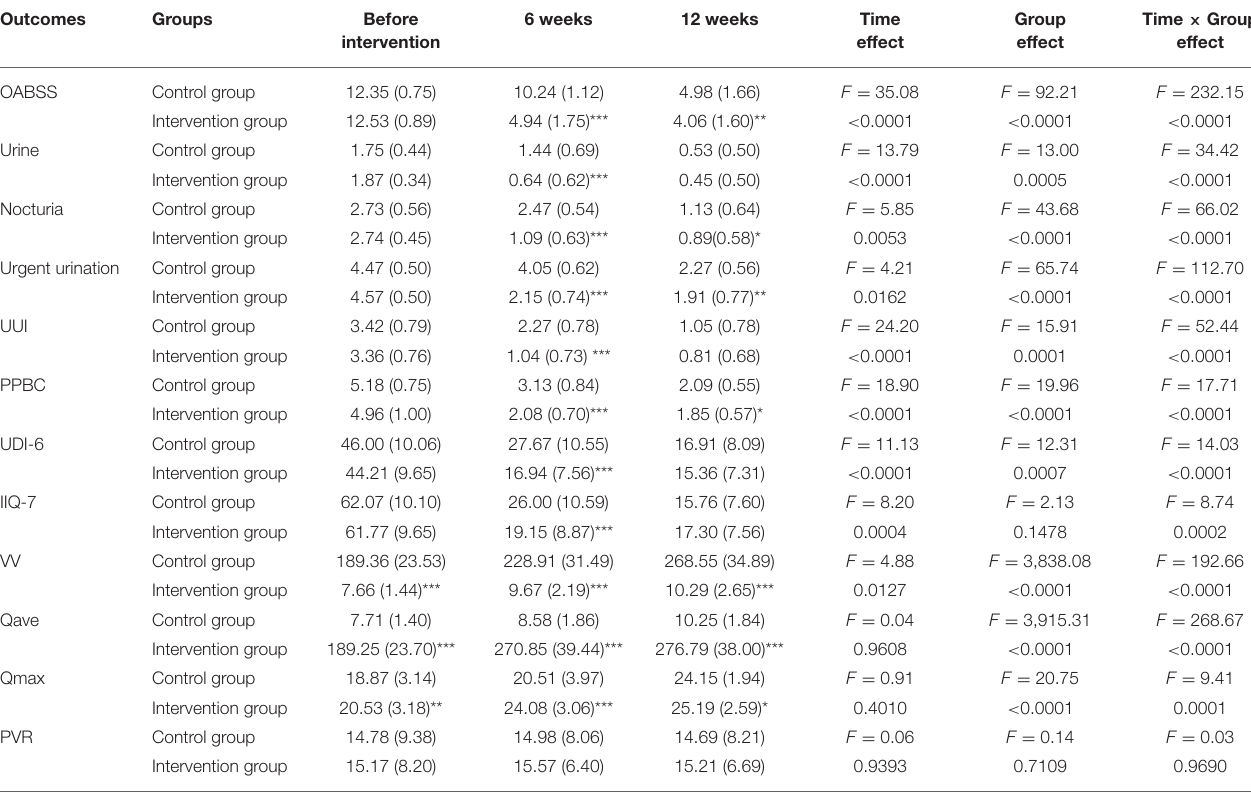
TABLE 2 | Outcomes associated with overactive bladder